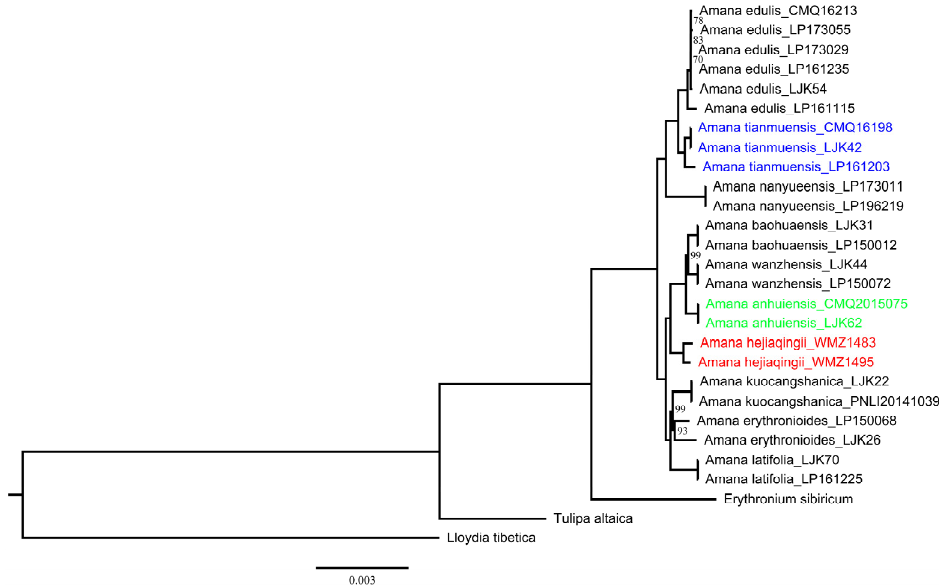
Figure 7. Phylogenetic tree of Amana based on plastid CDS sequences. All branches have Bayesian inference posterior probability (BIPP) =1.0. The numbers on the tree represent maximum likelihood bootstrap (MLBS) values. The unmarked branches all have BIPP = 1.0, MLBS =